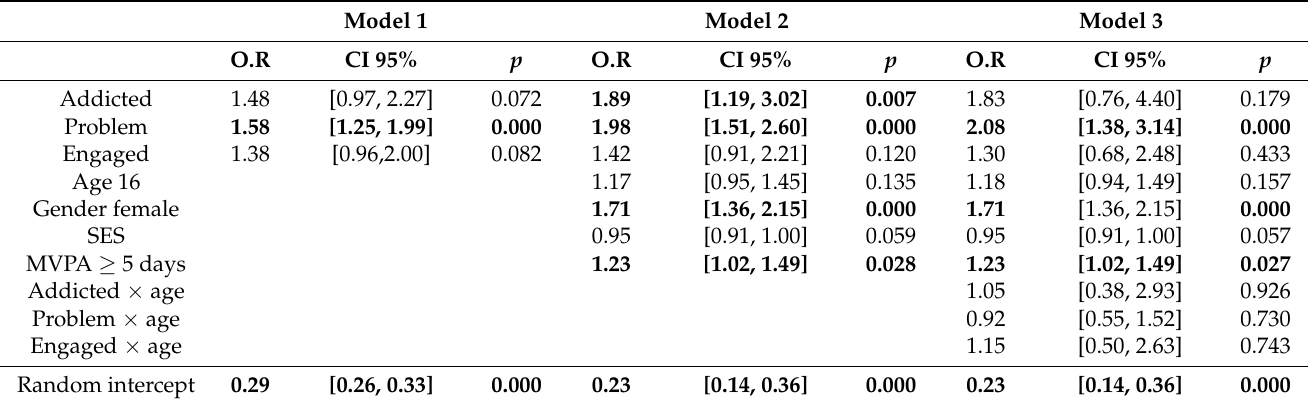
Table 5. Crude and adjusted associations of gaming behavior and difficulties falling asleep